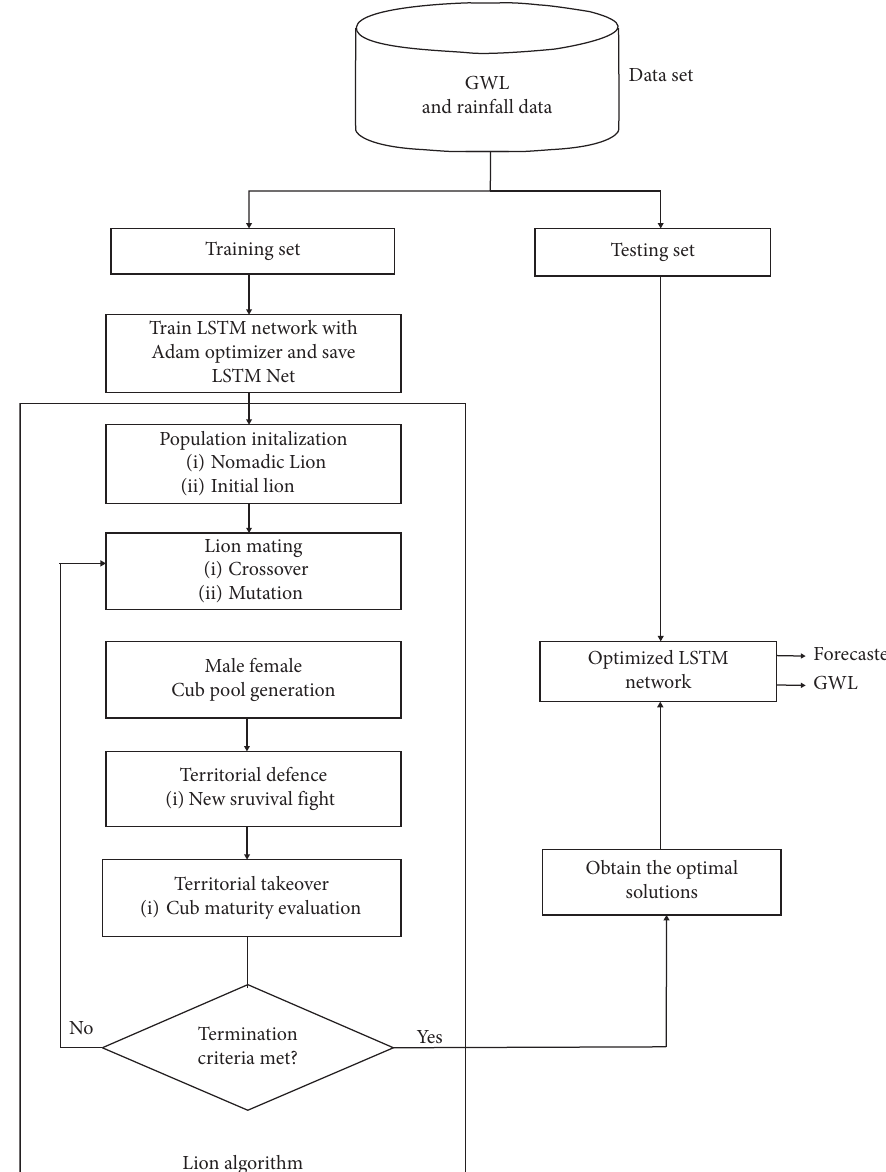
Figure 4: Flow diagram representing the hybrid LSTM-LA